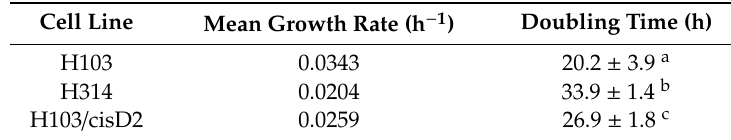
Figure 4. Regulation of EGFR in OSCC-derived EVs. ( a ) Western blot image of EGFR expression in OSCC cells and EVs. Signals of EV proteins were normalized against intensity of HSC70 while those of cell lysate were against actin. ( b ) Quantification of EGFR in EVs and in cells. Experiments were conducted in triplicates (Figure S4) and represented as ±SEM. * indicated significant differences, p < 0.05, n = 3 (One-way Annova, Tukey’s post-hoc). Table 2. Growth rate and doubling time of OSCC cells.